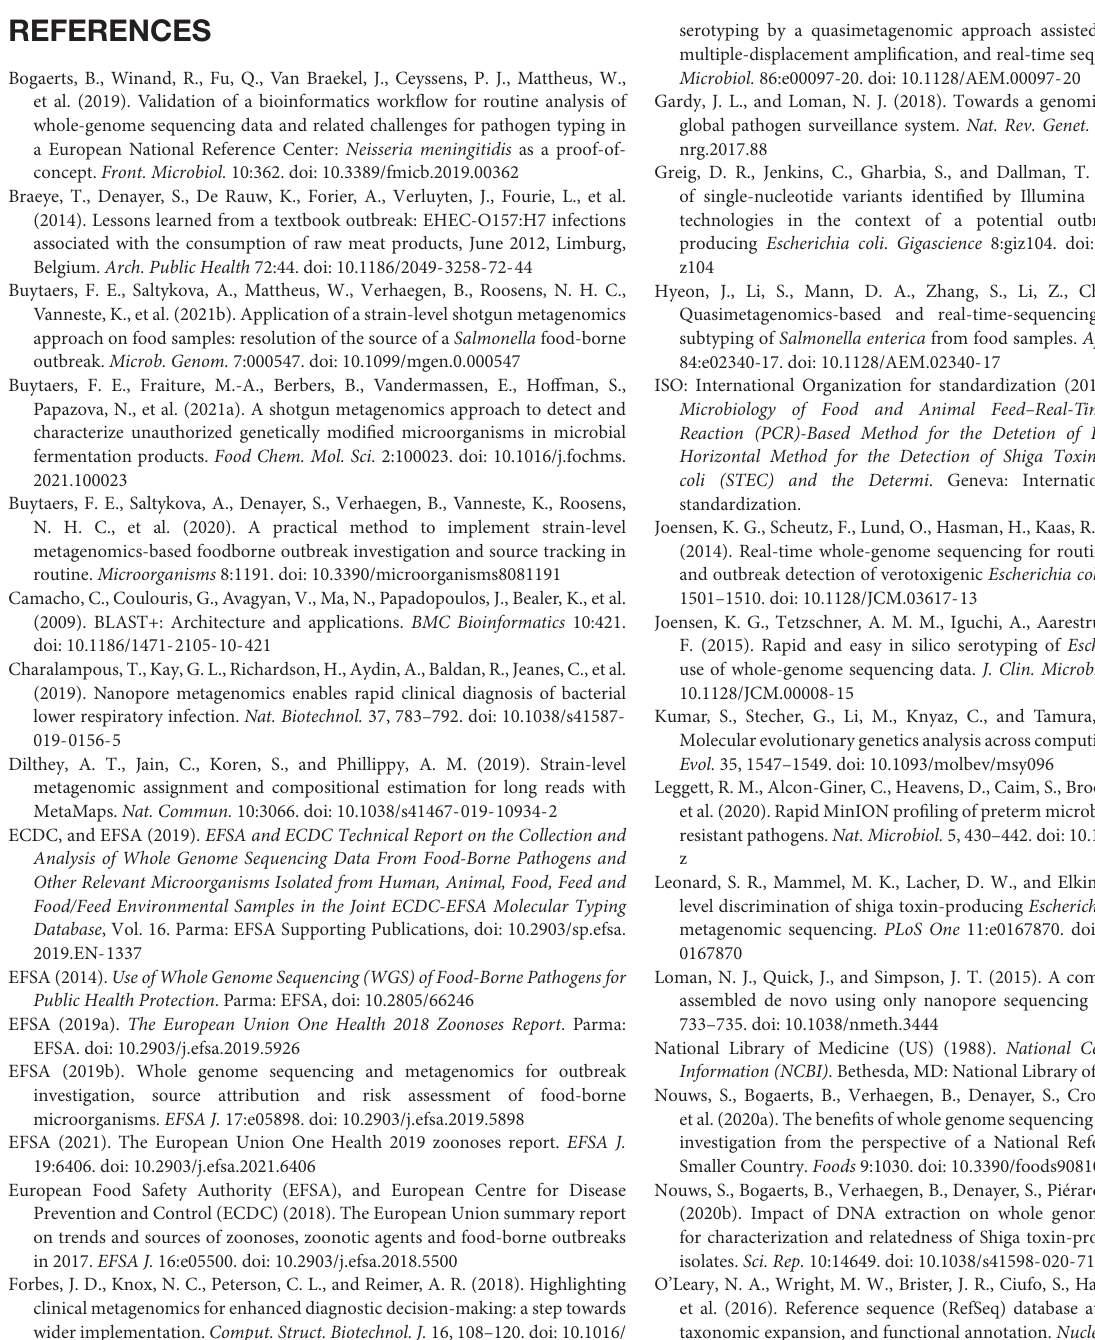
Supplementary Material 4 | Metamaps result (STEC reference genome assignment of the reads) after Flongle